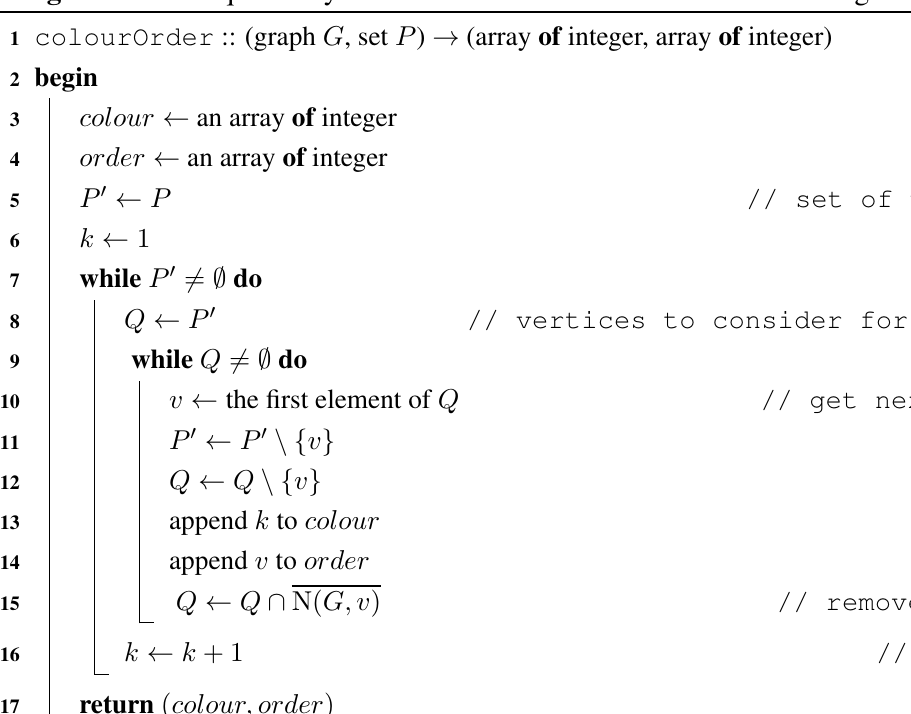
Algorithm 1: Sequentially colour vertices and sort into non-decreasing colour